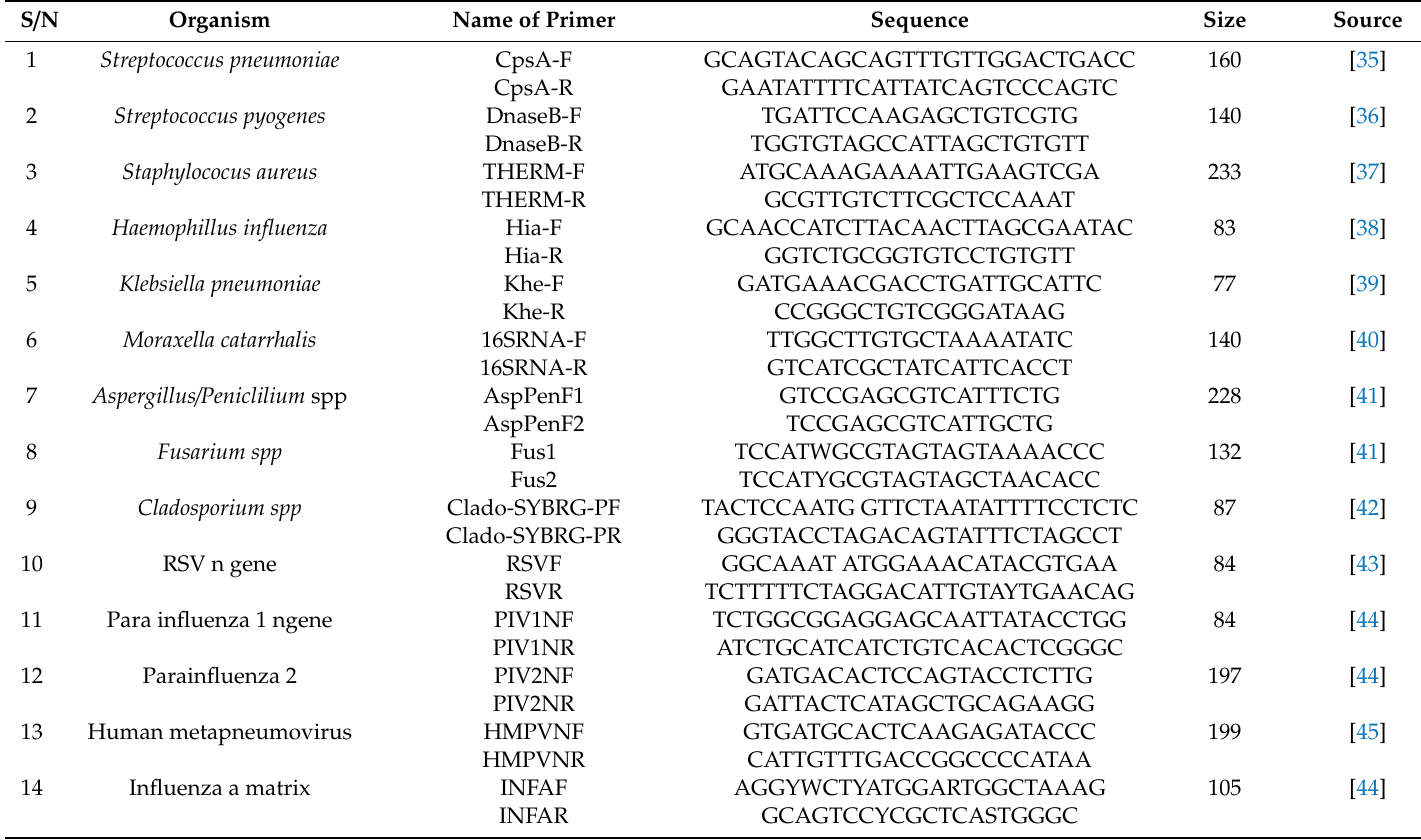
Table 1. Primers for real-time polymerase chain reaction (PCR)